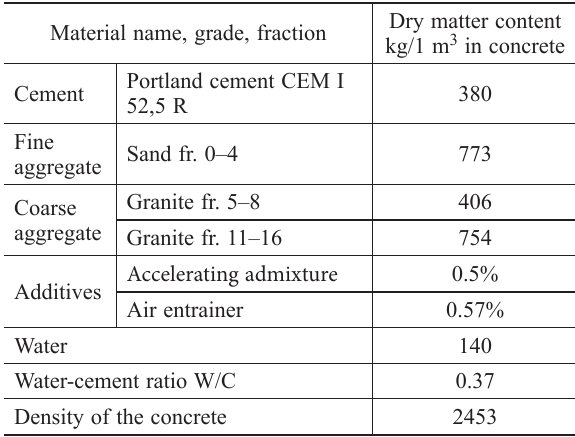
Table 1. Composition of concrete mixture